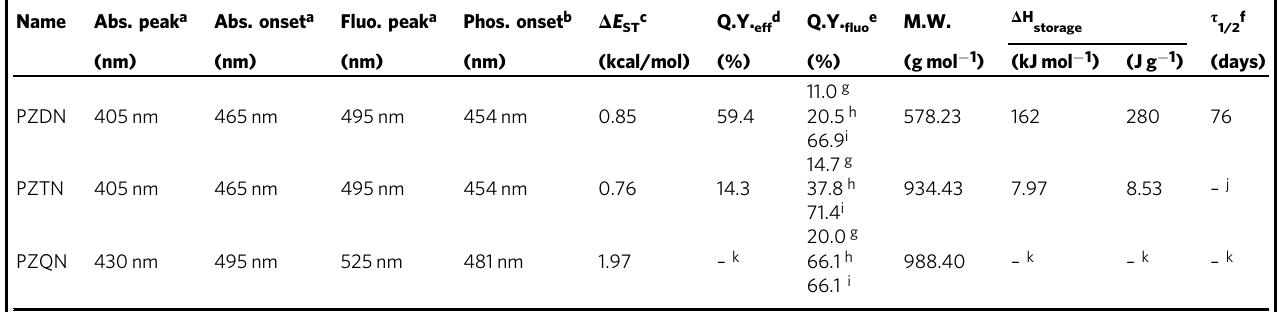
Table 1 MOST properties in the solution phase.